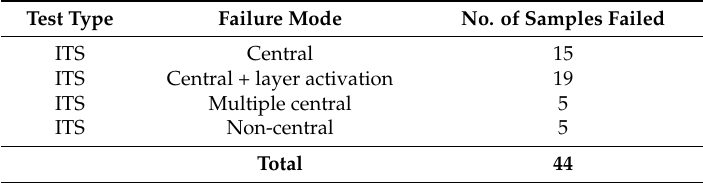
Table 4. Table with samples grouped based on their failure mode during the ITS